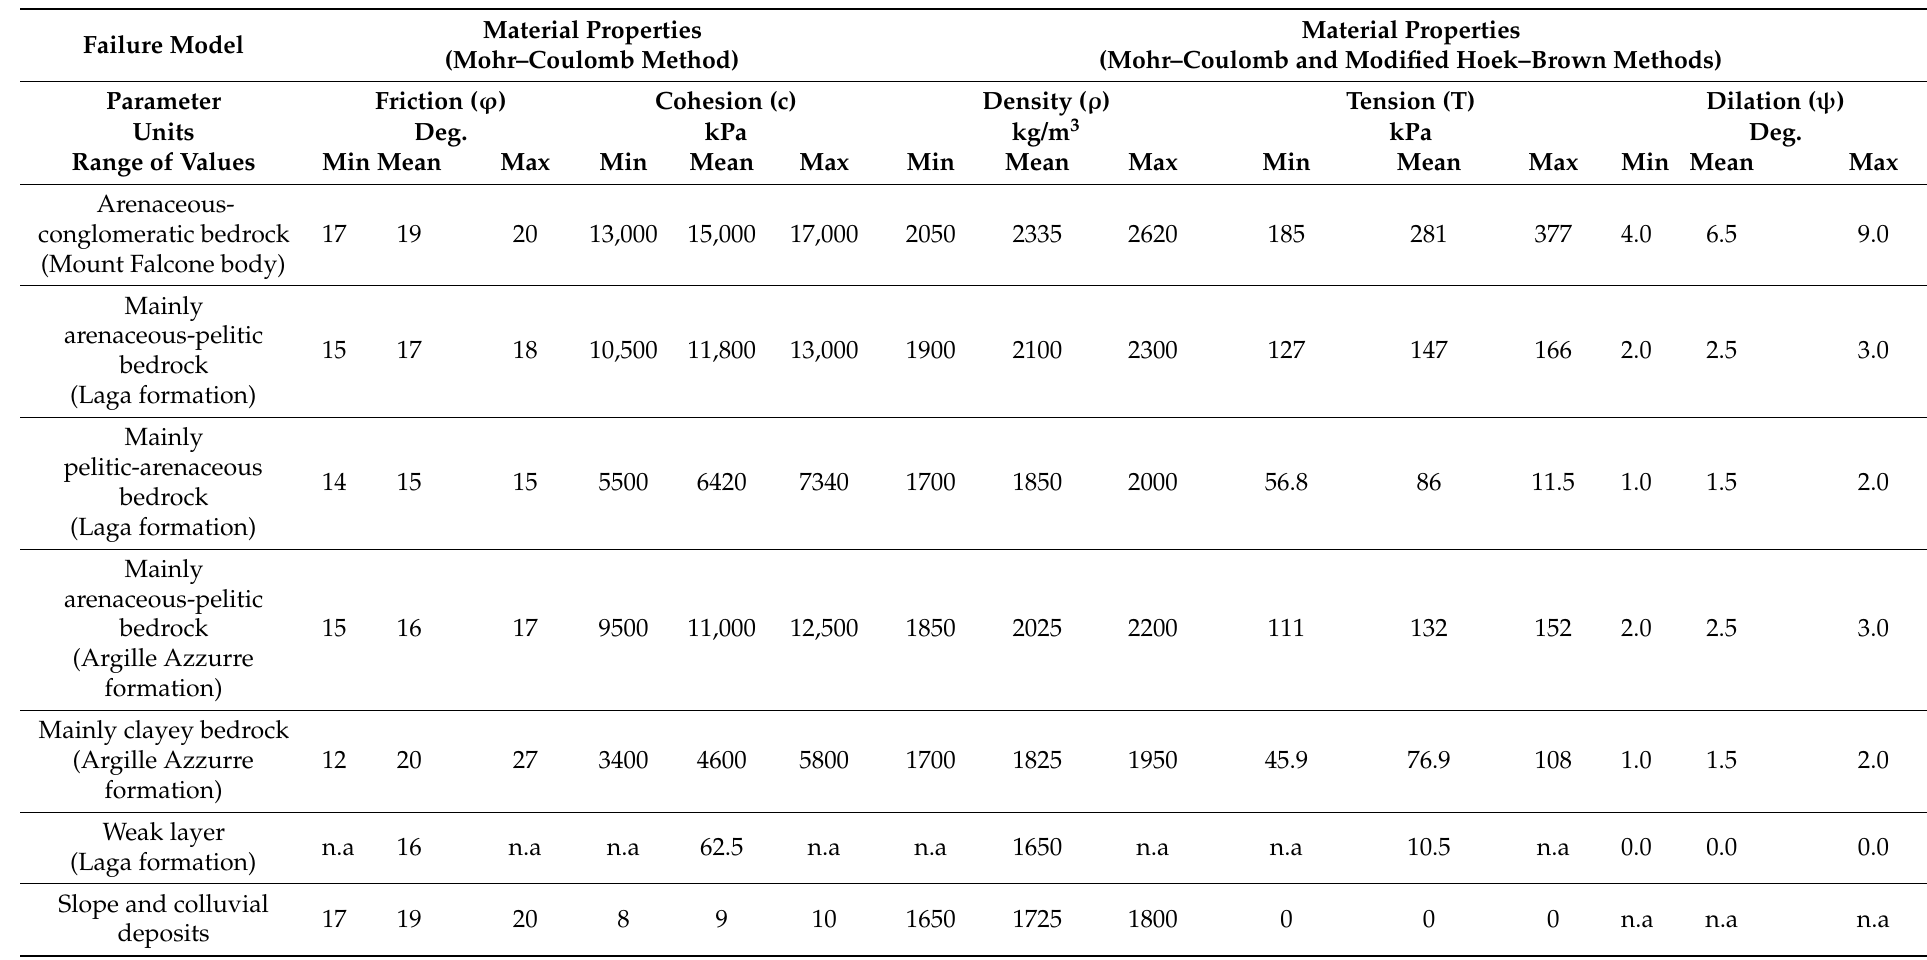
Table 1. Material properties, related to different geological units and implemented within the numerical